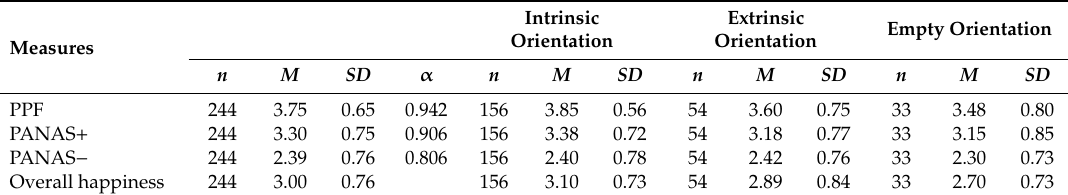
Table 2. Descriptive statistics and reliability of measures of psychological well-being (PPF) and subjective well-being (PANAS and overall happiness) according to the type of orientation.